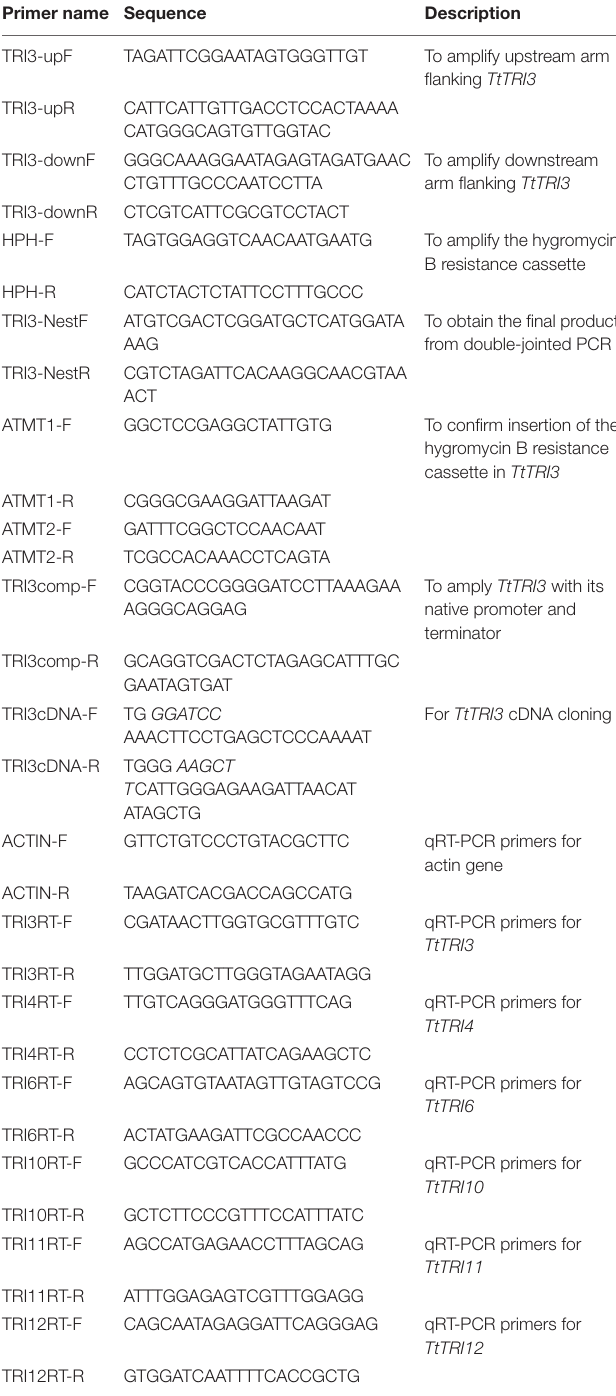
TABLE 1 | Primers used in this